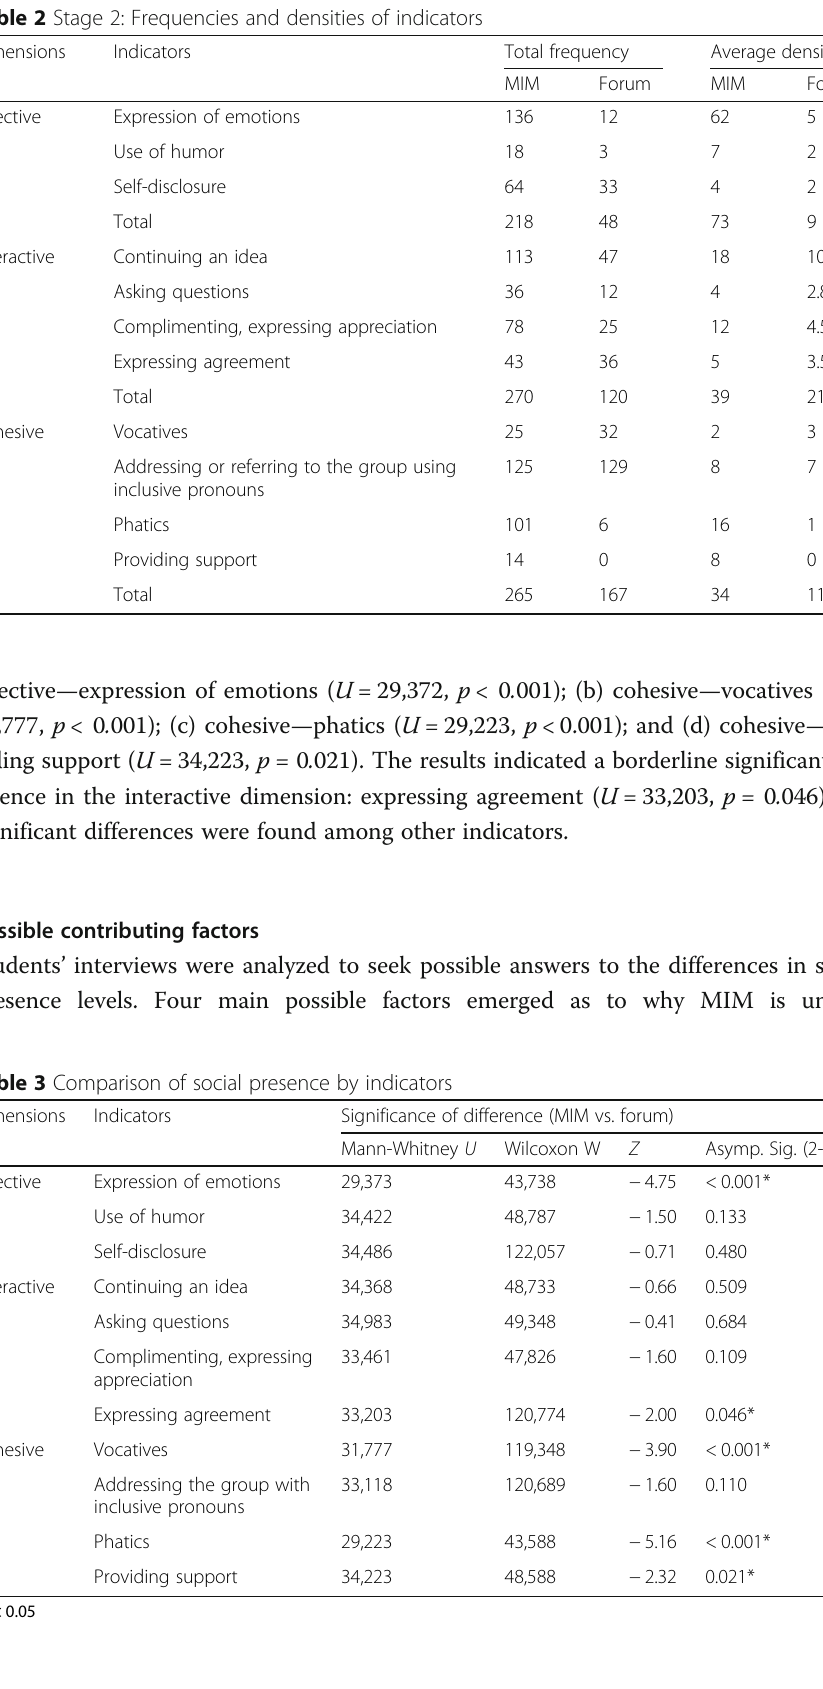
Table 2 Stage 2: Frequencies and densities of indicators Dimensions Indicators Affective Expression of emotions